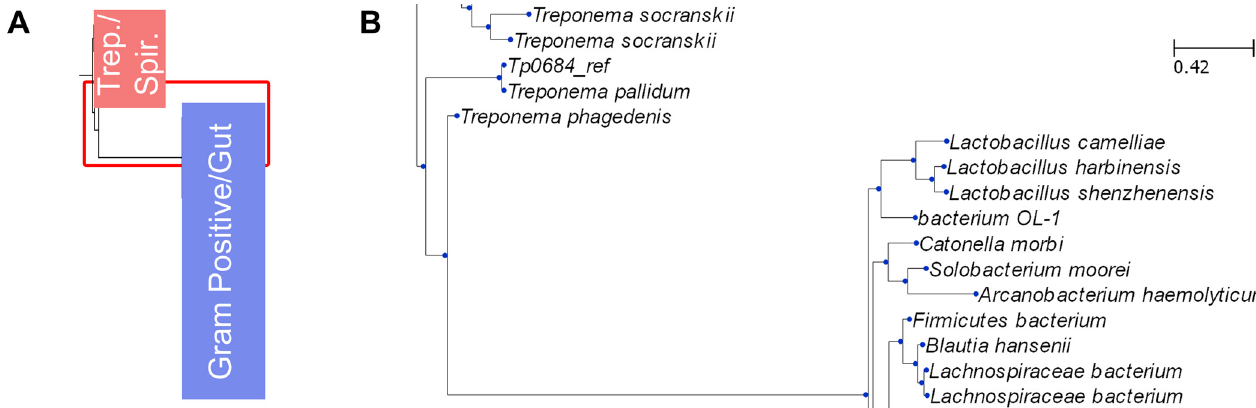
Fig 4. Relationships between proteins containing sequence and topology homology to TpMglB-2. (A) A schematic representation of the full cladogram. There are two main clades, which are shown as colored rectangles. The pink “ Trep./Spir. ” rectangle is occupied by treponemal and spirochetal organisms, while the “ Gram Positive/Gut ” blue rectangle is inhabited mainly by gram-positive organisms, many of which are mammalian gut commensal organisms. The red rectangle details the area of the figure that is blown up in (B). The full cladogram is available as a text file in the data supplied in S1 File. (B) A close-up of a branch point in the cladogram. The area of the cladogram highlighted in red in (A) is shown. TpMglB-2 is represented twice here ( “ Tp0684_ref ” and “ T . pallidum ” ) because it was included both as a structural template (in.pdb form) and as its native sequence. There is a slight difference between the two because of the 2 missing amino acids in the.pdb file.